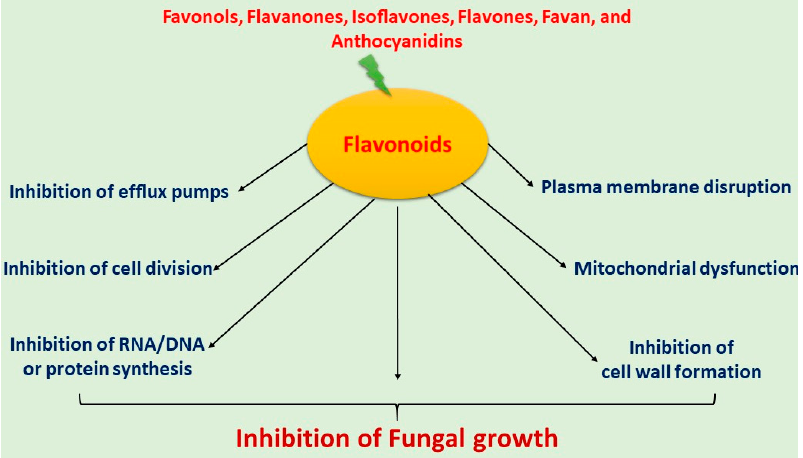
Figure 2. Mechanism of antifungal activity of flavonoids.